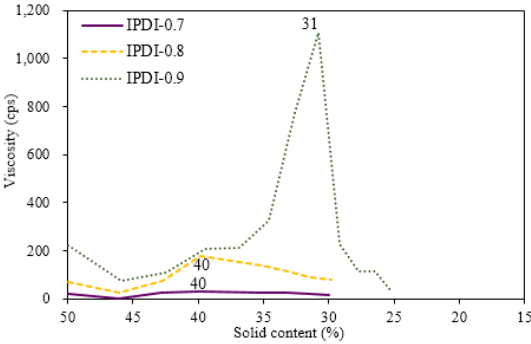
Figure 7. Viscosity variation of IPDI ionomer dispersions with different NCO/OH mole ratios during water dispersion process.